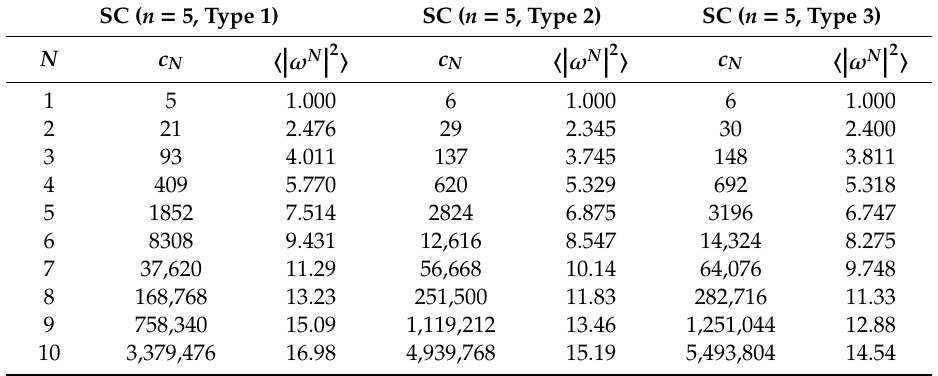
Table A6. Properties of SAWs on SC lattice with 5 layers between the confining planes ( n = 5, Type 1, 2,